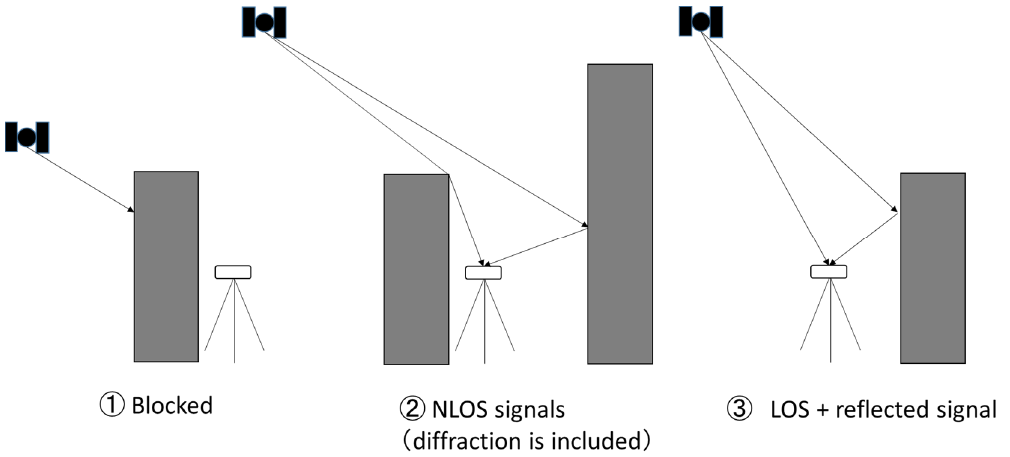
Figure 1. Three multipath types in Global Navigation Satellite System (GNSS).